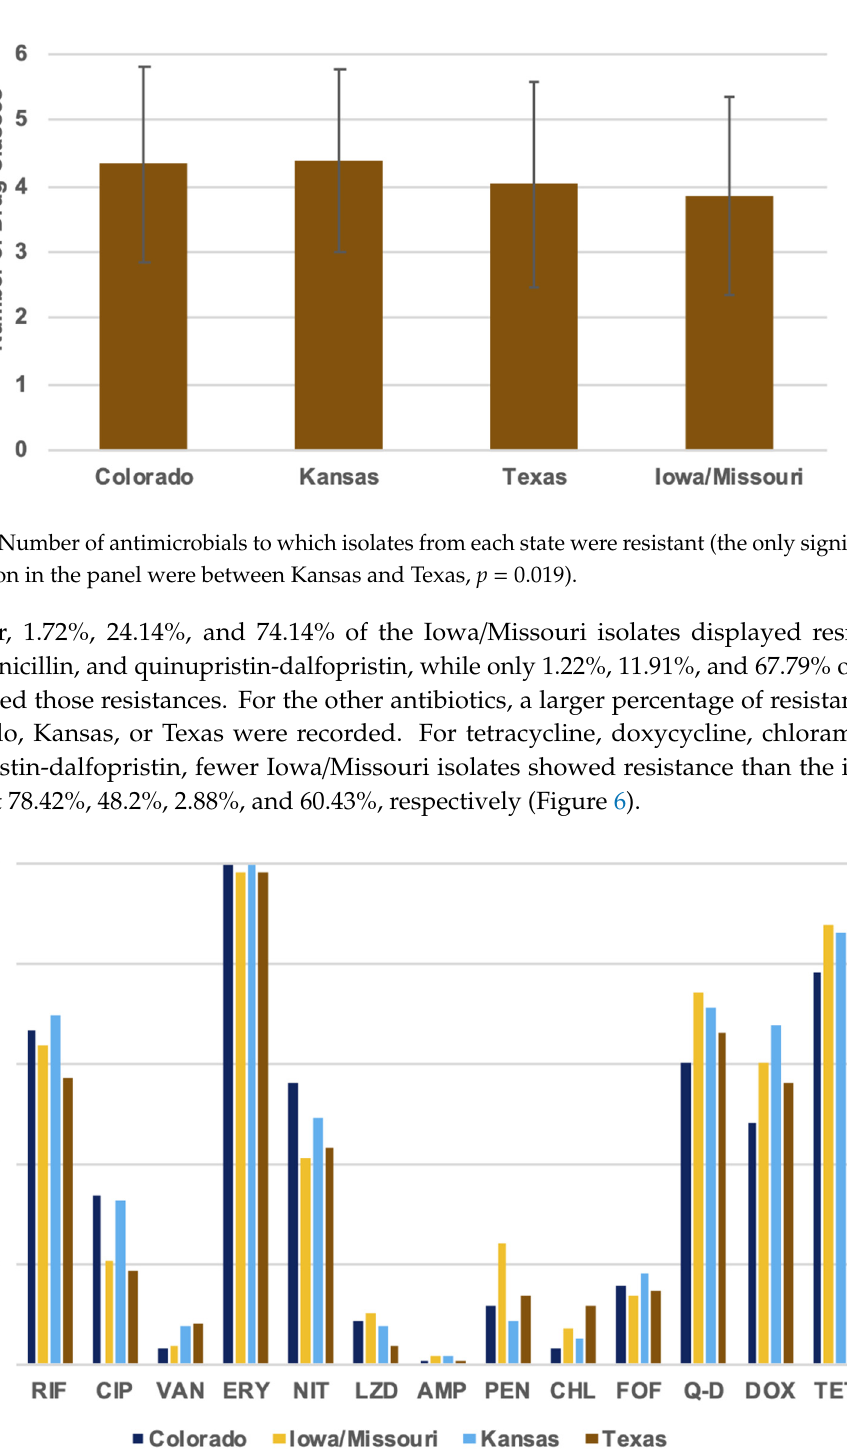
Figure 6. Numbers and percentages of resistance to each antimicrobial for isolates from each